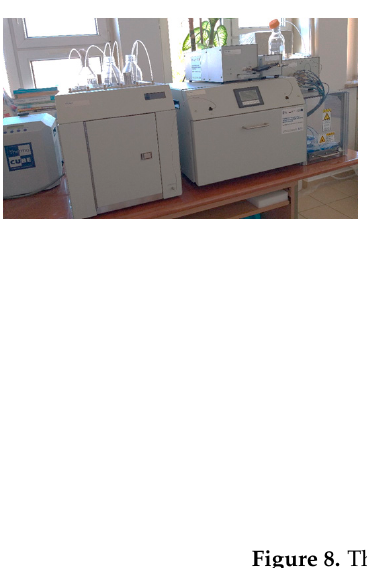
Figure 7. Blackcurrant and black cumin seeds used in the study of the supercritical extraction process (Source: author’s photo). ( a ) Blackcurrant seeds, ellipsoidal in shape, 1–2 mm in size, brown-purple in colour. ( b ) Nigella sativa (black cumin) seeds, pyramidal shape with a clear sharp tip at one end, size 2–3 mm, intense black color.